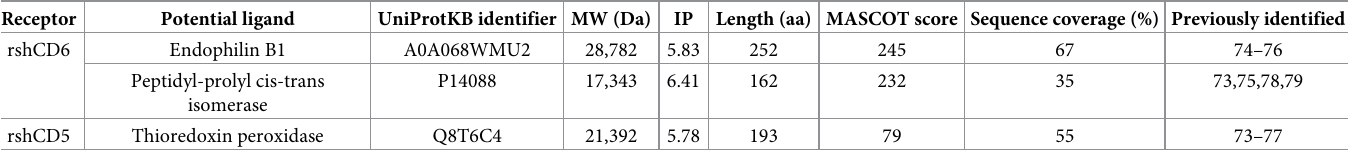
Table 1. Potential parasite ligands for rshCD5 and rshCD6 identified by 2D SDS-PAGE and further MALDI-TOF/TOF mass spectrometry analysis. Receptor Potential